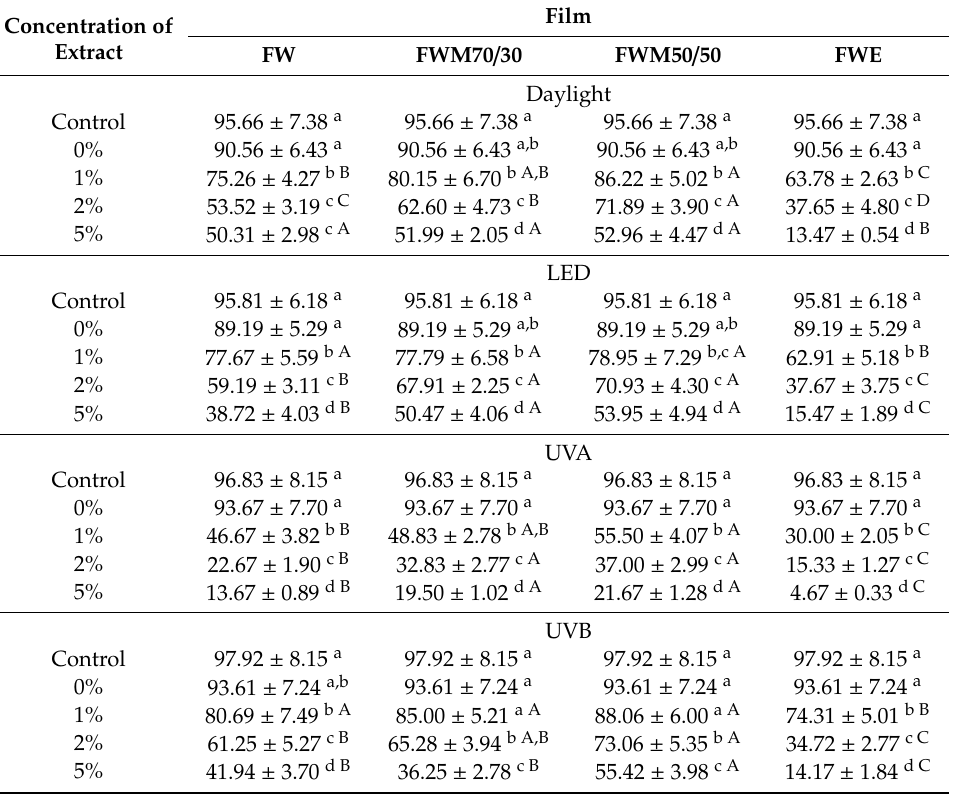
Table 9. Light transmittance of starch films with chicory root extracts and phytic acid (%). Concentration